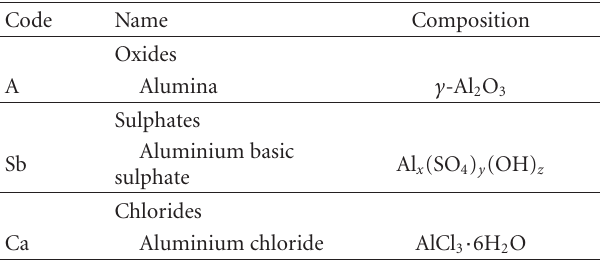
Table 11: Aluminium corrosion products identified in the MICAT